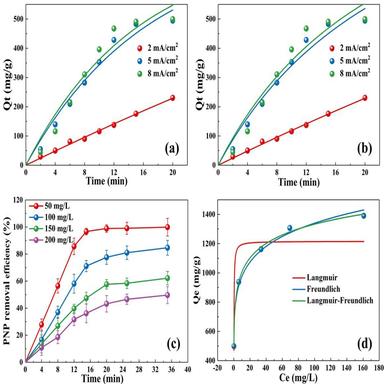
Kinetic model fitting of PNP removal process at different current densities: (a) pseudo-first-order kinetics model, (b) pseudo-second-order kinetics model; PNP removal efficiency (c) and isothermal model fit (d) for different initial PNP concentrations.